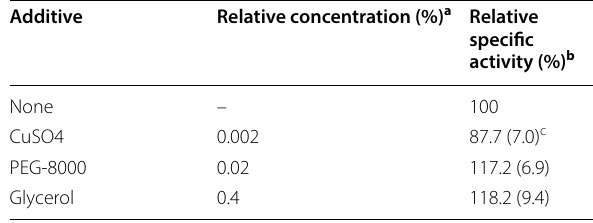
Table 3 The effect of selected additives used in the reaction mixture on the laccase specific activity of an enzymatic extract from Coriolus hirsutus